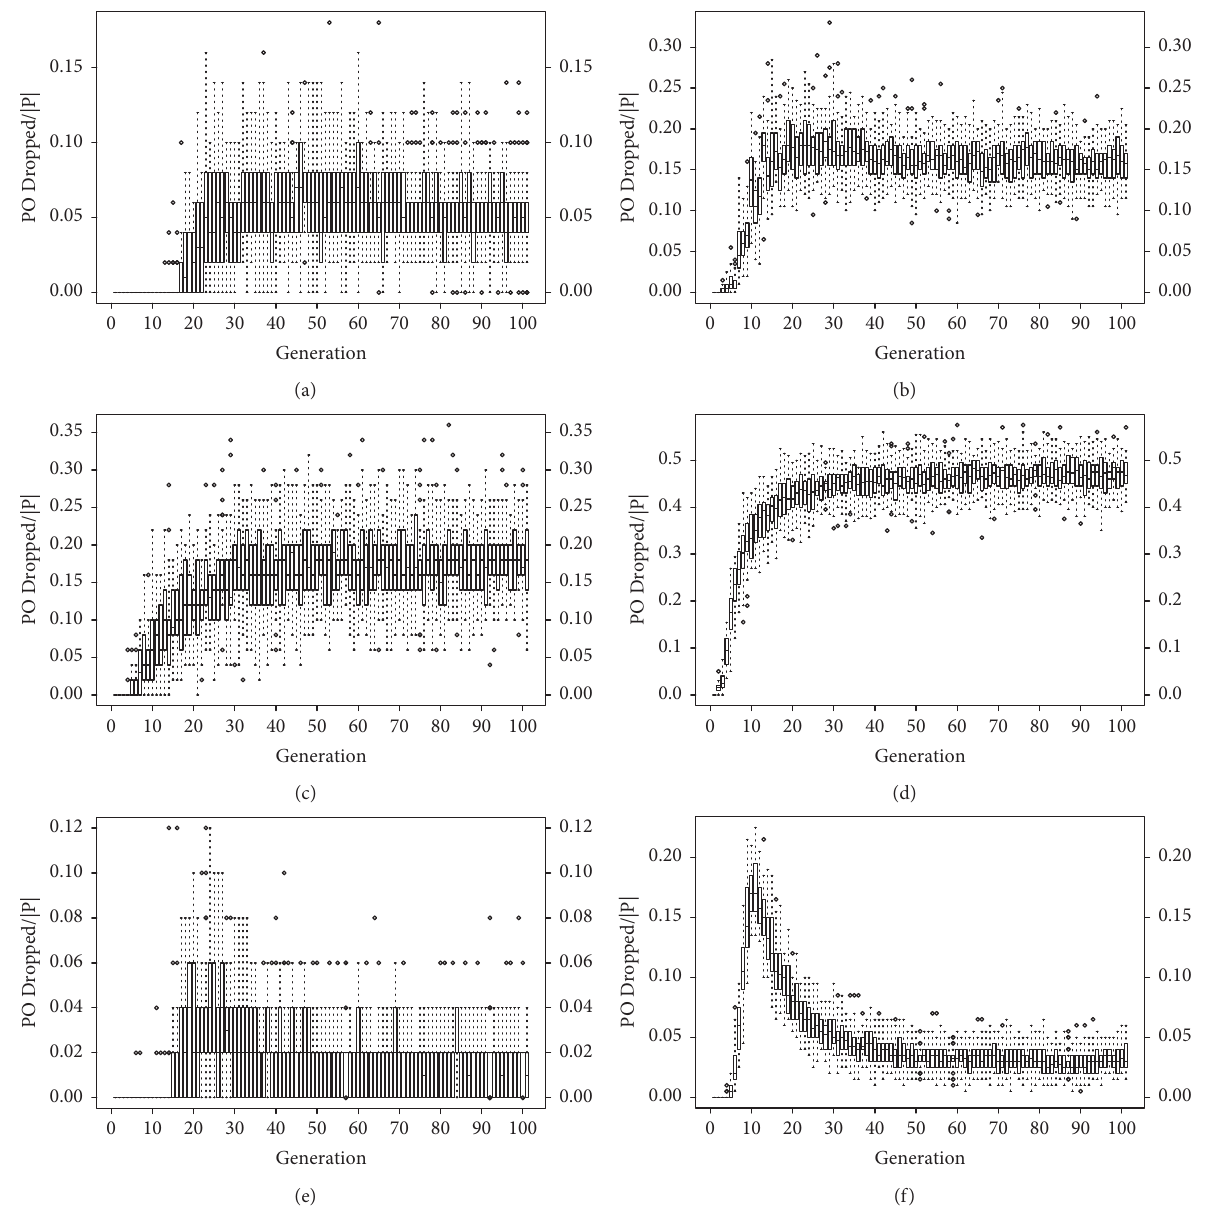
Figure 5: Pareto optimal solutions dropped from the population. Population sizes 50 and 200 for 3 and 6 objectives, respectively. Al- . (a) A ϵ S ϵ H, | P | � 50, M � 3; (b) A ϵ S ϵ H, | P | � 200, M � 6; (c) MOEA/D, | P | � 50, M � 3; (d) gorithms A ϵ S ϵ H, MOEA/D, and IBEA HV MOEA/D, | P | � 200, M � 6; (e) IBEA HV , | P | � 50, M � 3; and (f) IBEA HV , | P | � 200, M �